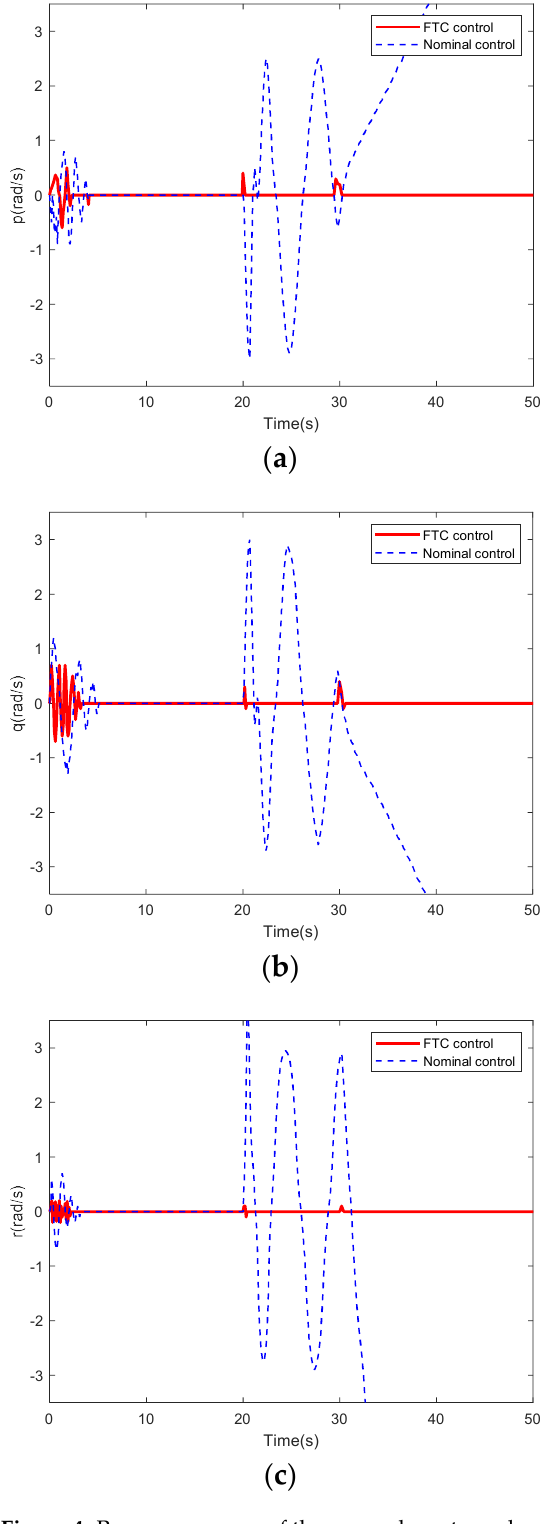
Figure 4. Response curves of three angular rate under sensor faults: ( a ) p ; ( b ) q ; and ( c ) r .